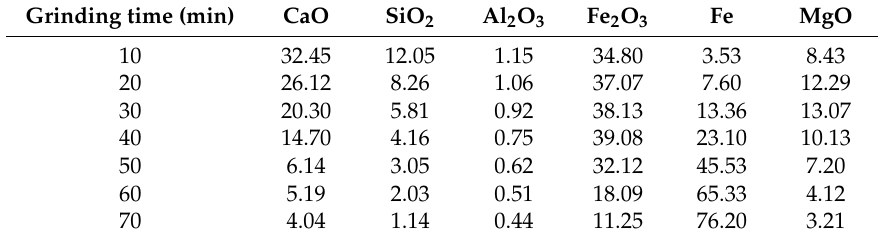
Table 3. Chemical compositions of hardly grinding phases (HGP) in steel slag vs. grinding time